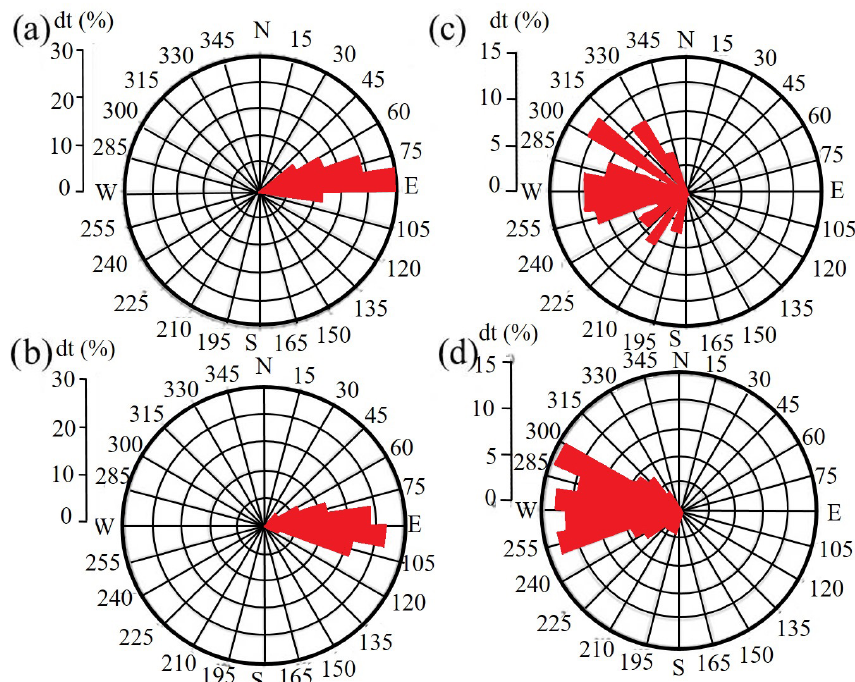
Figure 4. Result of the azimuthal distribution calculation for different frequency bands for the Pyhäsalmi experiment: (a) west part of profile, band of 2–5Hz; (b) west part of profile, band of 5–10Hz; (c) east part of profile, band of 2–5Hz; (d) east part of profile, band of